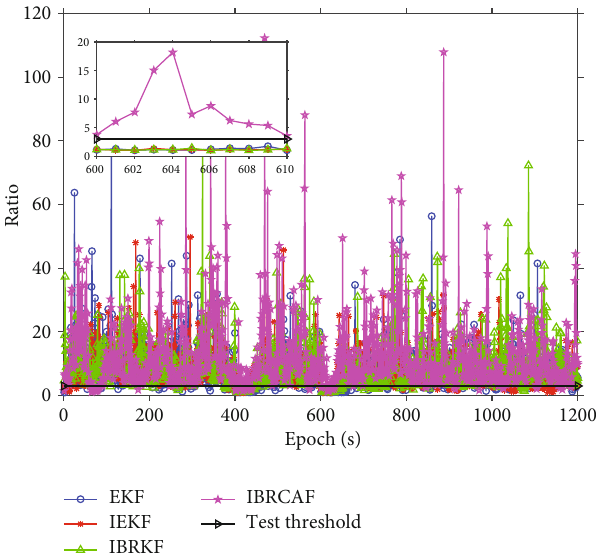
Figure 10: The ratio values of EKF, IEKF, IBRKF, and IBRCAF (Data 3).